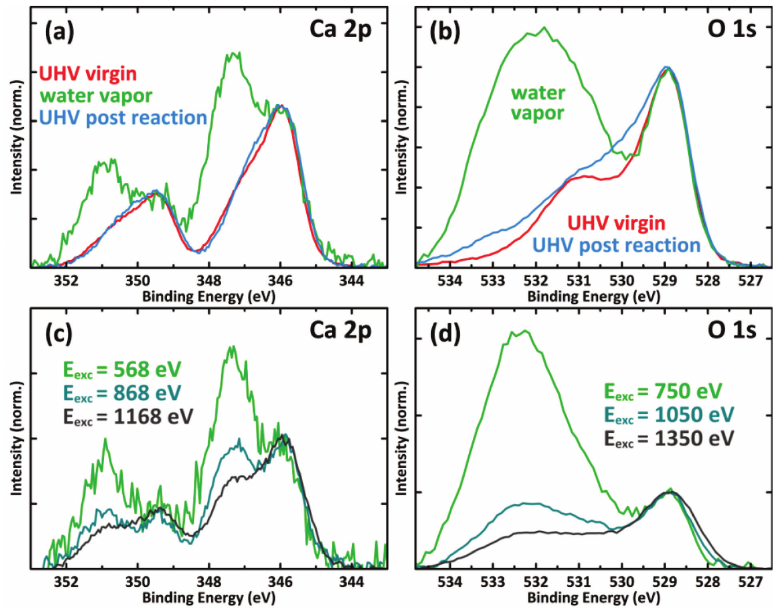
= 0.5. ( a ) Ca 2p states Ca O with sample bias of +2.5 V against 2 2